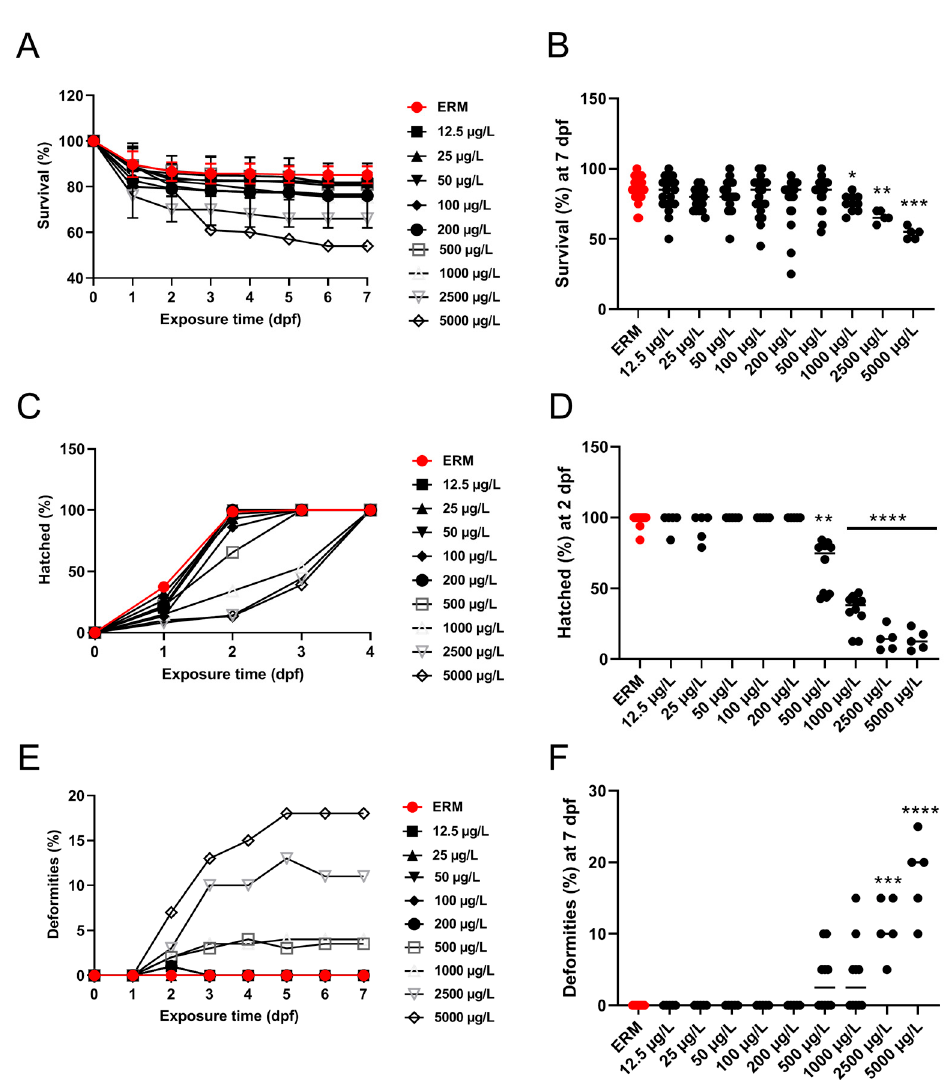
Figure 1. Percentage survival, deformities, and hatch rate of zebrafish exposed to ERM (control), 12.5, 25, 50, 100, 200, 500, 1000, 2500, and 5000 µg/L of sulfamethoxazole over time ( A , C , E ). Percent survival and deformities at 7 dpf and hatch rate at 2 dpf of zebrafish embryos (( B , D , F ), respectively). Four separate experiments were performed, and data were merged into single graphs for all three parameters. The horizontal line represents the group’s median value (Kruskal Wallis followed by Dunn’s multiple comparison test, * p < 0.05, ** p < 0.01, *** p < 0.001, **** p < 0.0001).